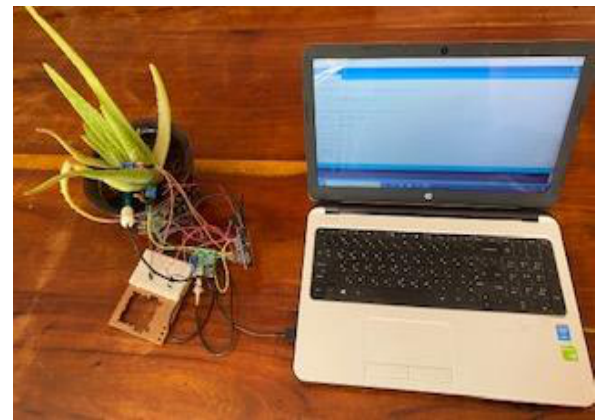
Figure 15. The plant monitoring system of the Aloe Vera Plant